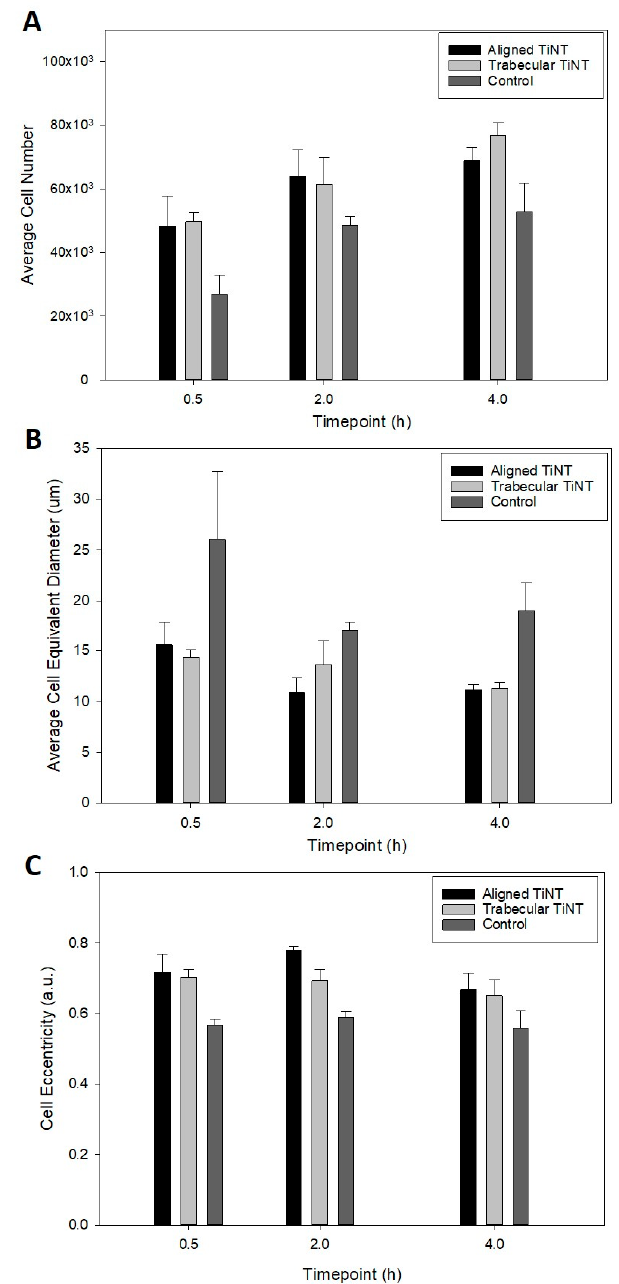
Figure 3. Average total cell number ( A ), cell equivalent diameter ( B ), and cell eccentricity ( C ) on TiNT and control surfaces at 0.5, 2, and 4 h. For Cell Number, significant comparisons were: aligned TiNT vs. control, p = 0.018; trabecular TiNT vs. control, p = 0.008; aligned TiNT vs. control, p = 0.044. For Cell Diameter, significant comparisons were: aligned TiNT vs. control, p = 0.048; trabecular TiNT vs. control, p = 0.031; aligned TiNT vs. control, p = 0.008; aligned TiNT vs. control, p = 0.003; trabecular TiNT vs. control, p = 0.003. For Cell Eccentricity, significant comparisons were: aligned TiNT vs. control, p = 0.004; trabecular TiNT vs. control, p = 0.007; aligned TiNT vs. control, p < 0.001; trabecular TiNT vs. control, p = 0.003.